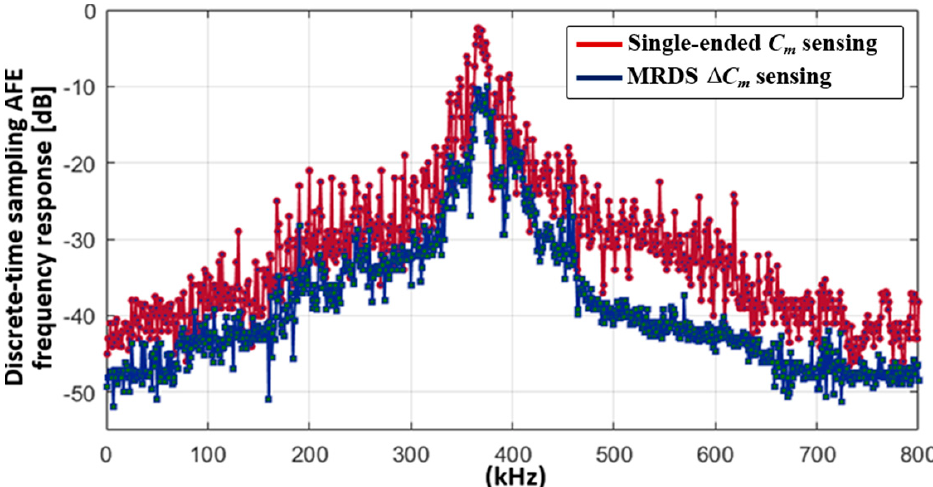
Figure 20. Measured noise suppression ratio from DC to 800 kHz for single-ended and MRDS-applied configurations.